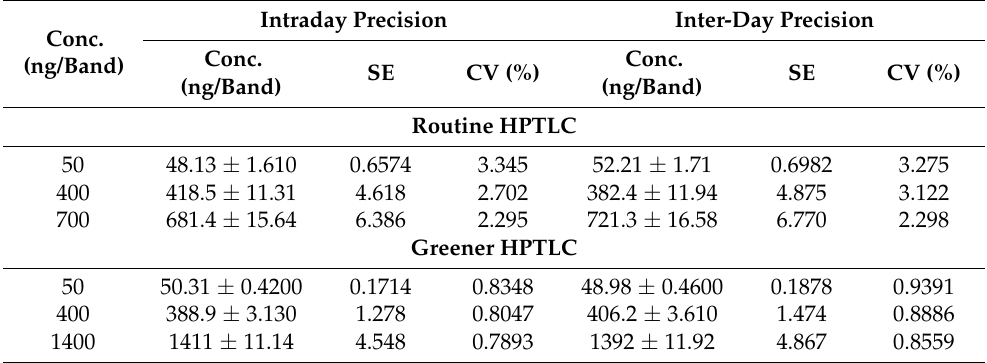
Table 4. Determination of GFT precision for the routine HPTLC and the greener HPTLC methods (mean ± SD; n = 6).